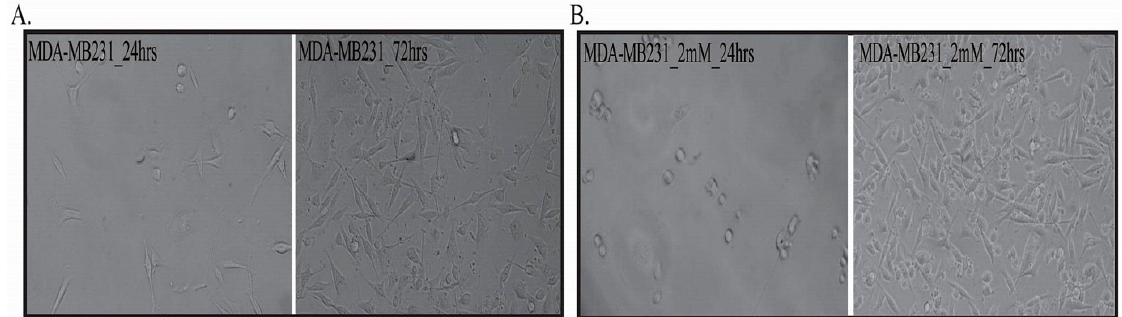
Figure 2. Morphological aspects of MDA-MB 231 cells. ( A ) Untreated; ( B ) treated. n = 2; 10×.